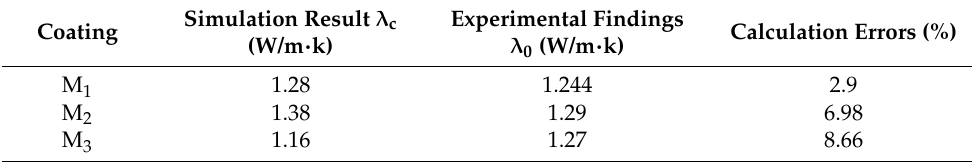
Figure 5. The distributions of thermal flux about the coatings ( a ) M 1 , ( b ) M 2 and ( c ) M 3 . Table 5. Comparison of theoretical and experimental results.